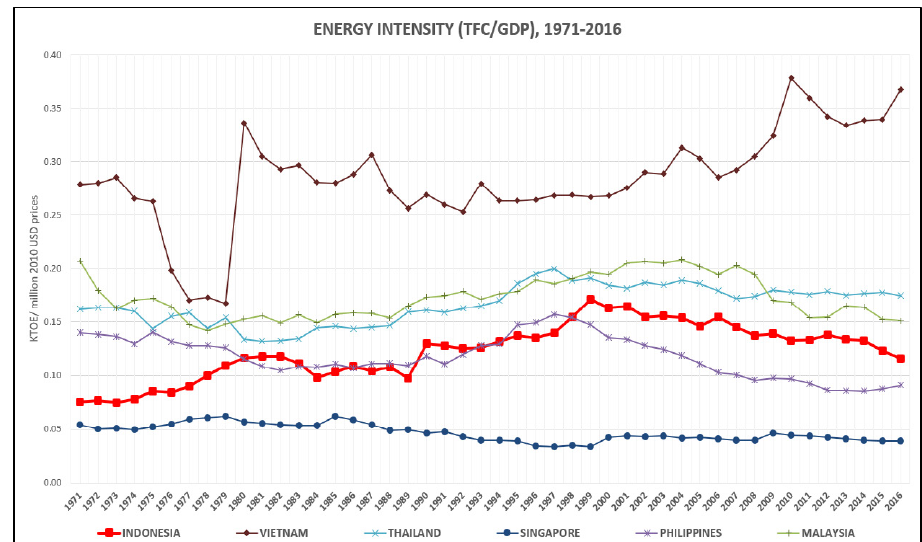
Fig. 1: Energy Intensity Comparison for six ASEAN countries, 1971-2016